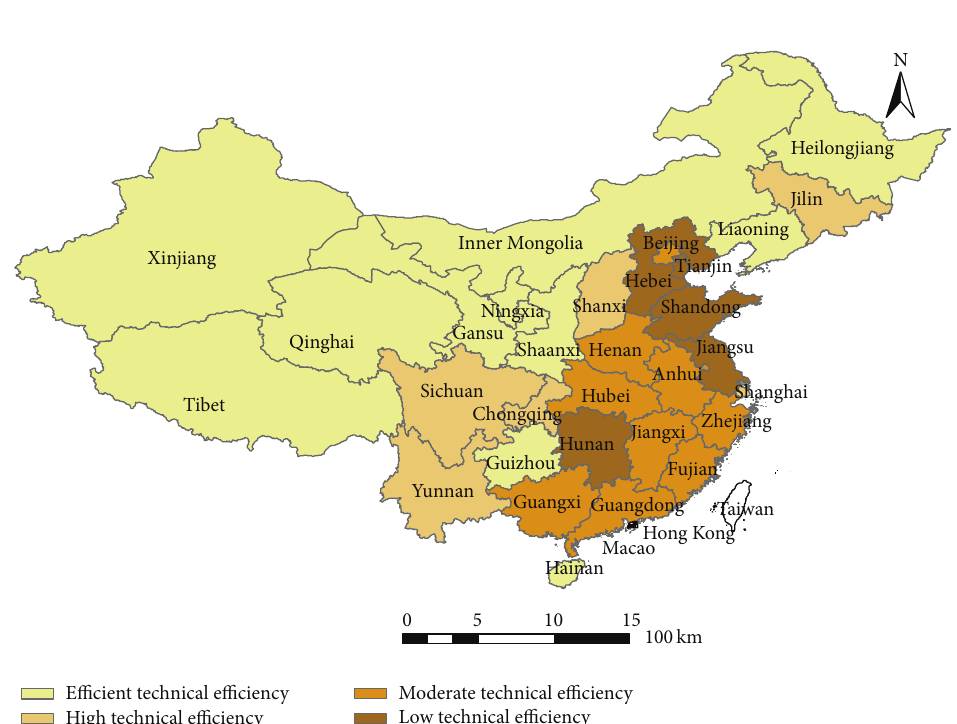
Figure 2: Spatial distribution of technical efficiency of intensive agricultural production in